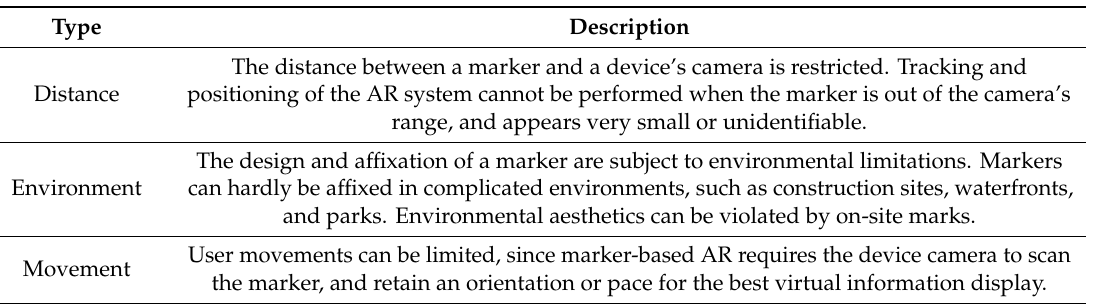
Table 5. Limitations of marker-based